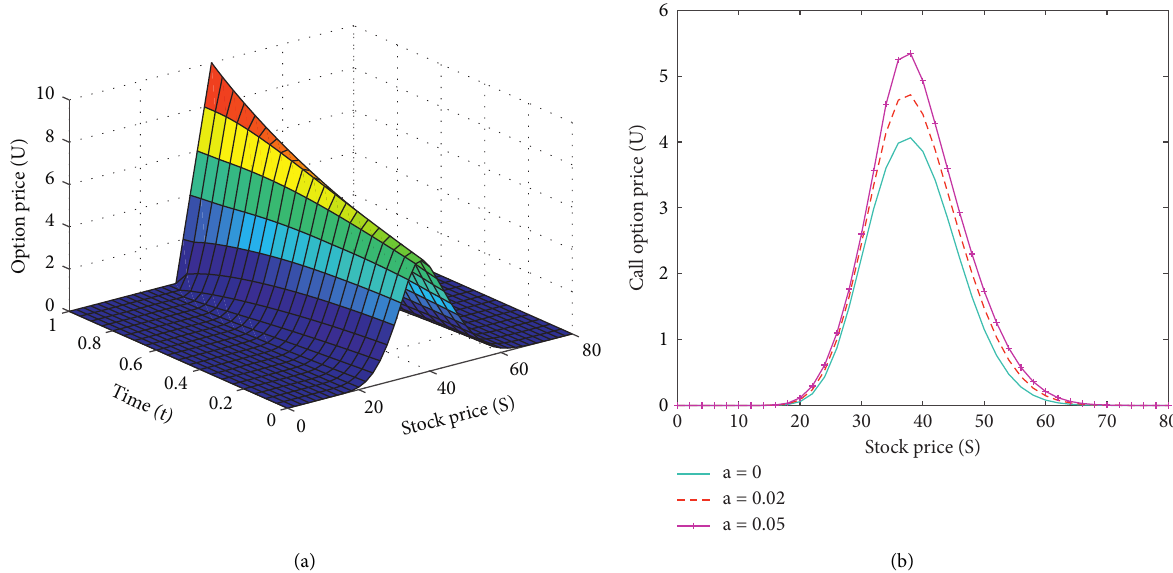
Figure 3: (a) Butterfly spread option price charts of the explicit nonstandard method for a � 0 . 05 and (b) butterfly spread option price charts of the explicit nonstandard method for different transaction costs in t � 0.